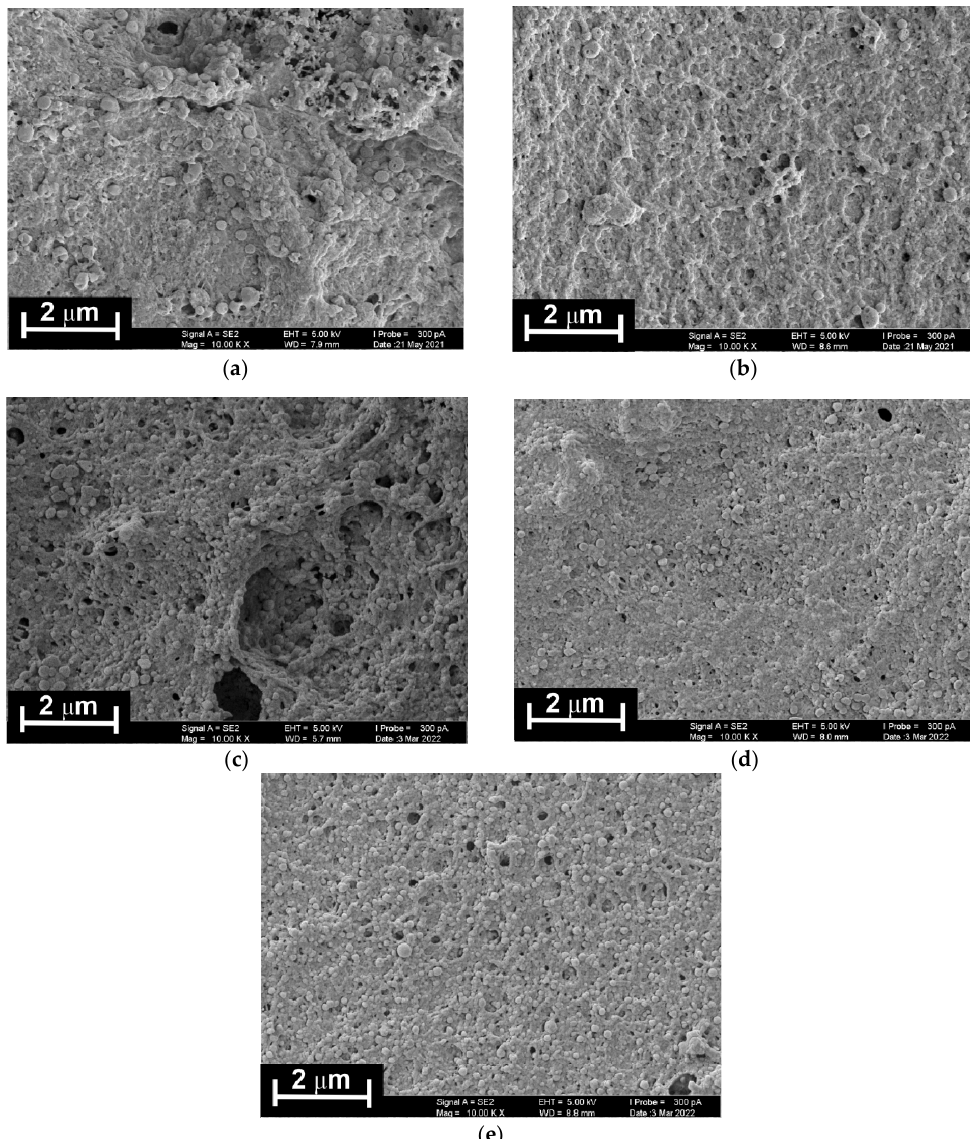
Figure 4. SEM images recorded on GCE covered with AA+CB ( a , b ) and AA+fMWCNTs ( c – e ) sus ‐ tential cycling ( e ) for the coating